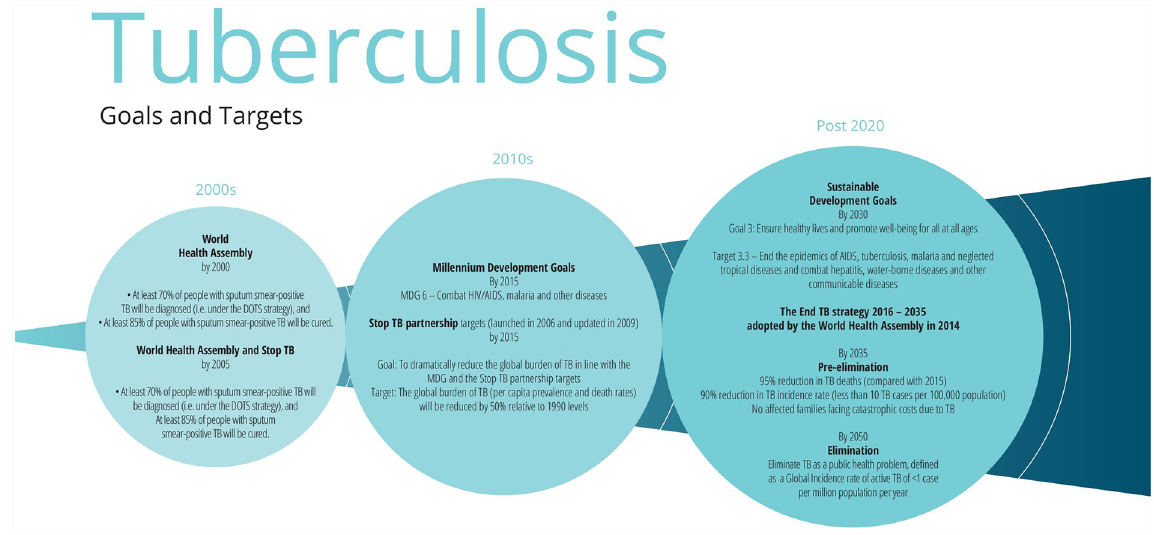
Fig 3. Major goals and targets for TB. DOTS, Directly Observed Treatment, Short Course; MDG, Millennium Development Goal; TB, tuberculosis.